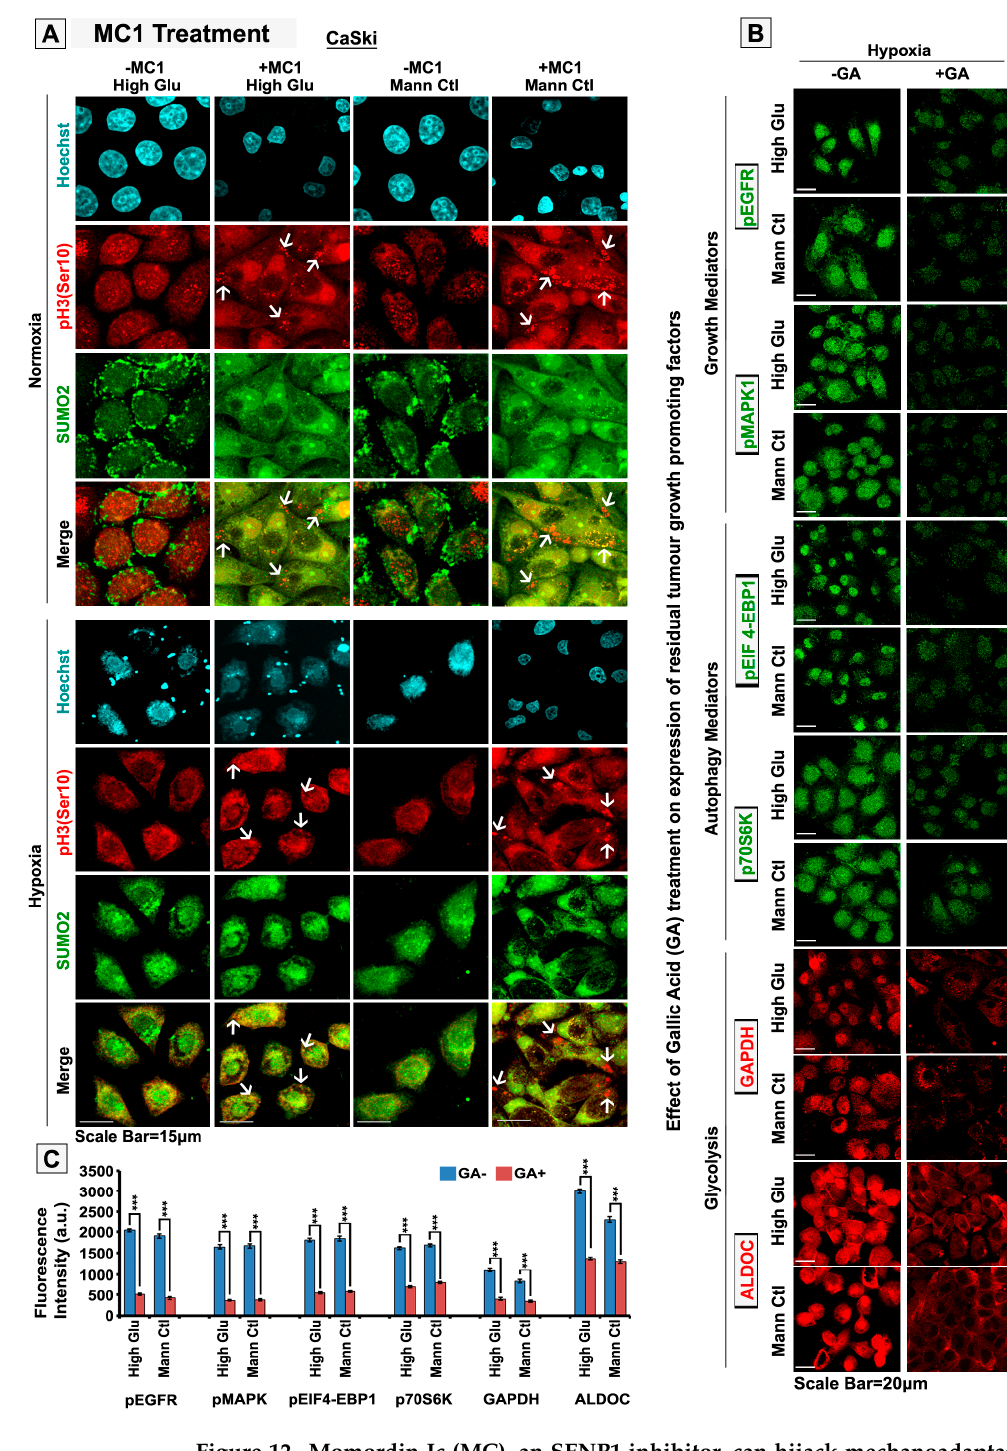
Figure 12. Momordin Ic (MC), an SENP1 inhibitor, can hijack mechanoadaptation of normoxic high-glucose hyper-osmotic tumour cells by promoting abnormal SUMOylation of pH3(Ser10). Cells were subjected to the basic treatment conditions for 96 h, followed by treatment with 25 µ M Momordin Ic for 6, 12, 24 and 48 h.( A ) Confocal images show massive cytoplasmic colocalization of SUMO2-pH3(Ser 10) in normoxic experimental conditions vs untreated conditions (see white arrows). In hypoxia, the treatment enhanced cytoplasmic sequestration of SUMO2-pH3(Ser10). ( B , C ) In order to more robustly eliminate the residual growth in hypoxia, the tumour cells were treated with 100 µ M of Gallic Acid (GA), post 96 h of treatment in the standard experimental conditions.